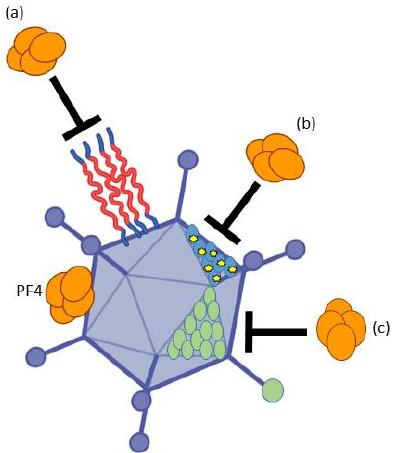
Figure 4. Strategies to avoid binding of blood proteins to the adenovirus capsid. ( a ) Chemical shielding. Using polymers linked to the adenovirus, hexon protein can avoid binding of blood proteins. ( b ) Genetic mutation of the adenovirus hexon protein coding sequence within the adenovirus genome. ( c ) Complete serotype switch using an alternative adenovirus type not binding blood components. In part created with BioRender.